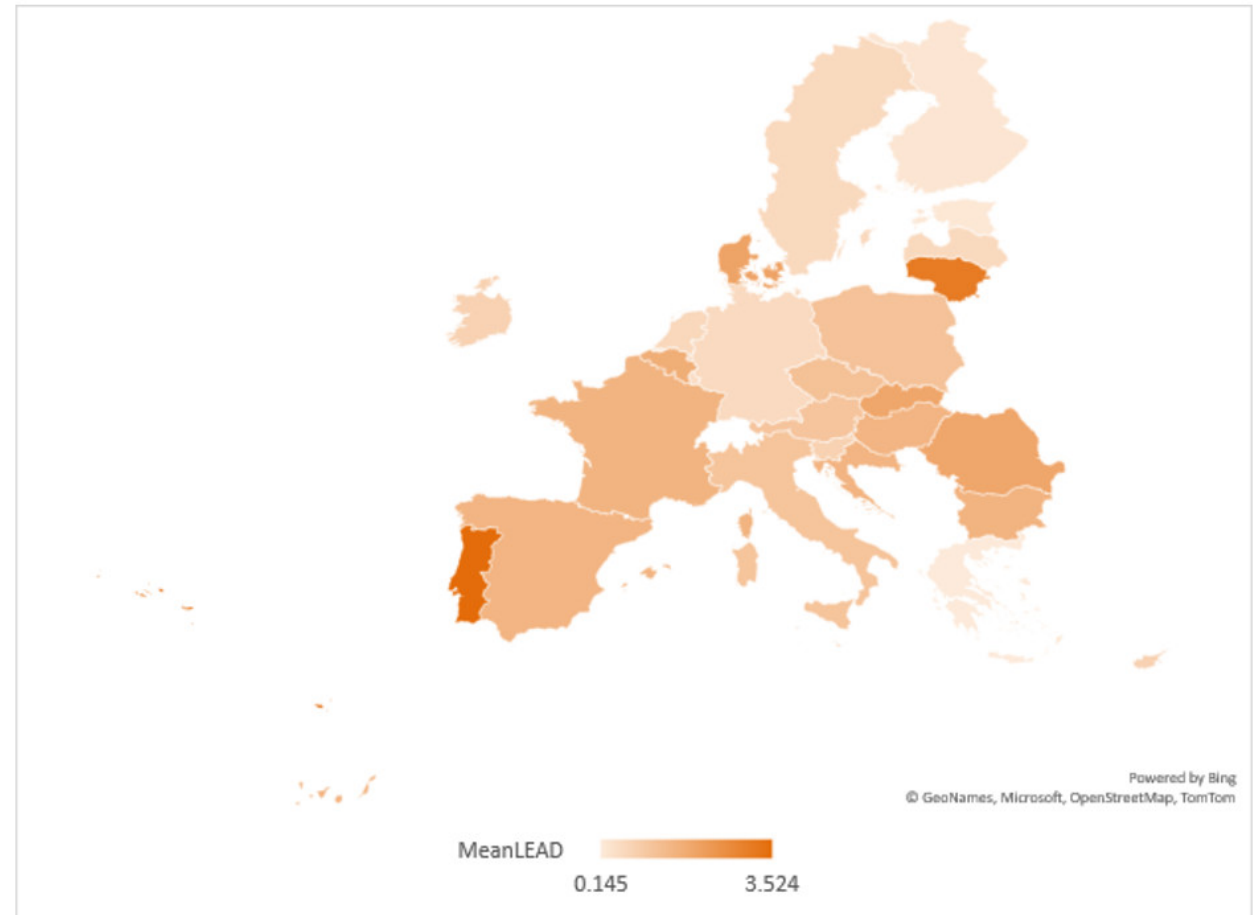
Figure 8. Disparities in policies to combat lead water pollution in the EU.